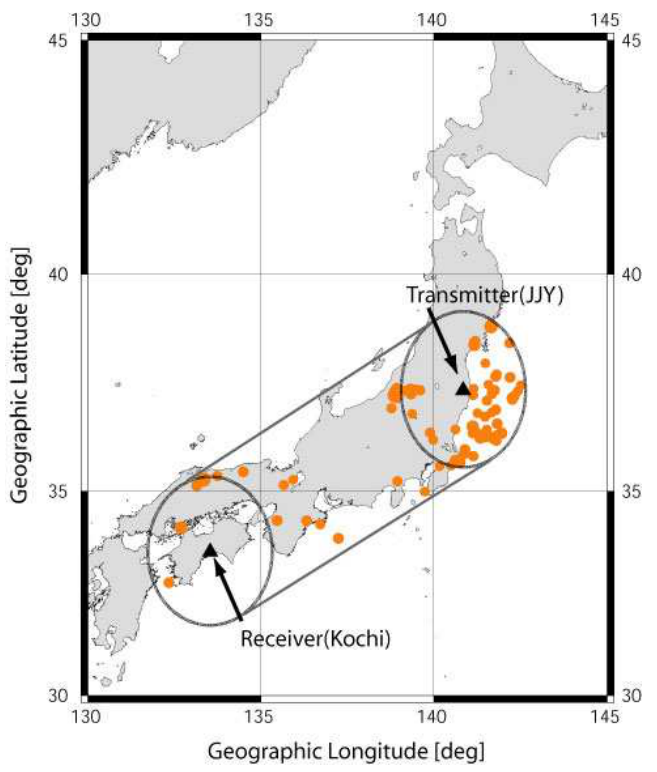
Figure 3. Relative location of the LF transmitter, JJY in Fukushima and an observing station, Kochi. The sensitive area for this LF propagation path is also indicated; the circles with radius of 200km around the transmitter and receiver and by connecting the outer edges of these two circles. Also 92 earthquakes with conventional magnitude (M) greater than 5.0 are plotted, which took place within the sensitive